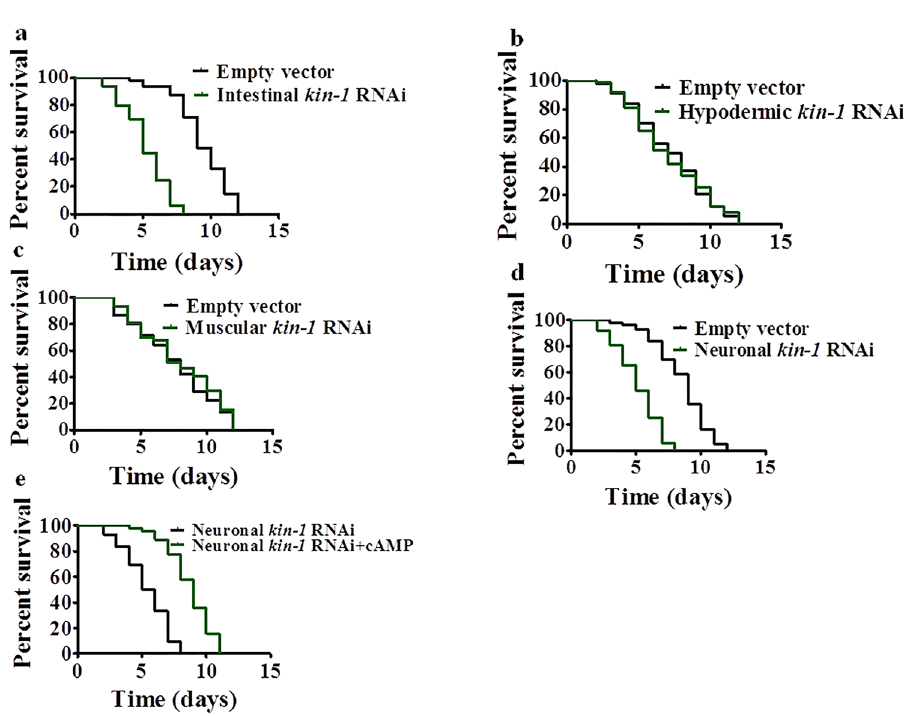
Figure 5. KIN-1/PKA functions in the intestine and neurons during cold stress. ( a ) Intestinal-specific kin-1 RNAi significantly reduced survival rate of worms at 4 °C. P < 0.01 relative to control with empty vector. ( b , c ) Hypodermic-( b ) or muscular- ( c ) specific RNAi had no effect on sensitivity to cold stress. ( d ) Neuronal-specific kin-1 RNAi significantly reduced survival rate of worms at 4 °C. P < 0.01 relative to empty vector. ( e ) cAMP rescued the specific neuronal RNAi kin-1 phenotype to cold stress. P < 0.01 relative to specific neuronal RNAi kin-1